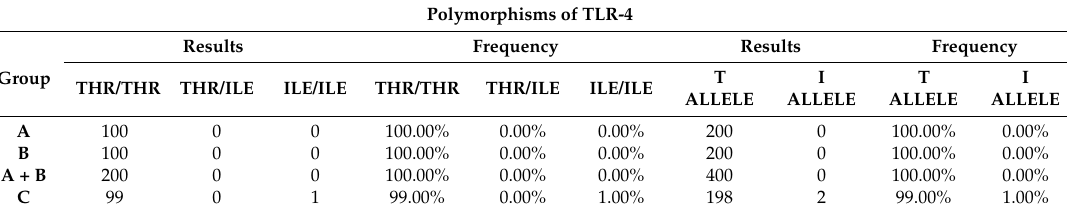
Table 3. Frequencies of Toll-Like-Receptor-4/Thr 399 Ile